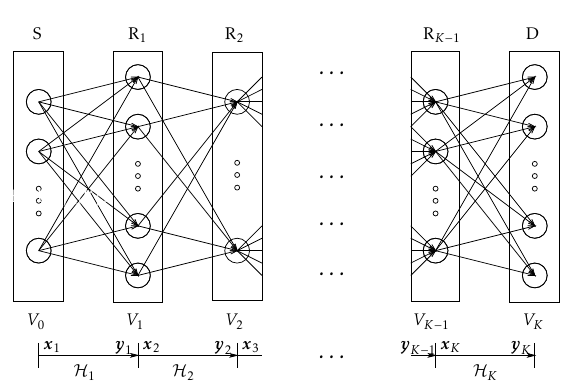
Figure 1. System model of multi-hop layered wireless